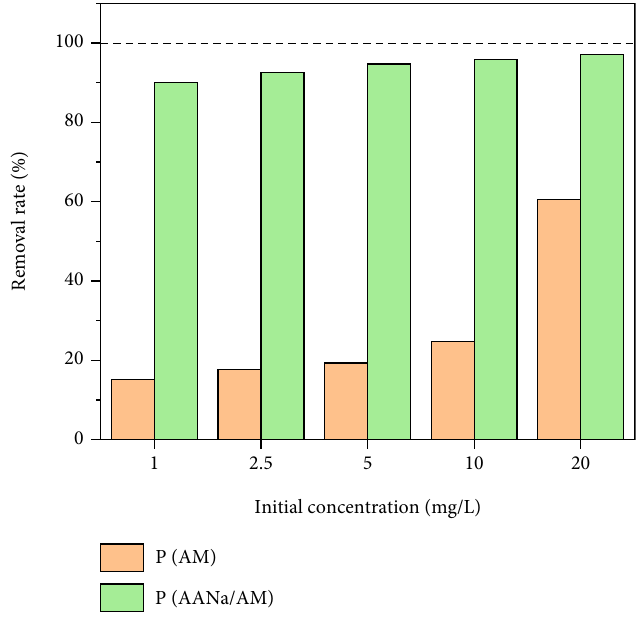
Figure 5: MB removal rates of P(AM) and